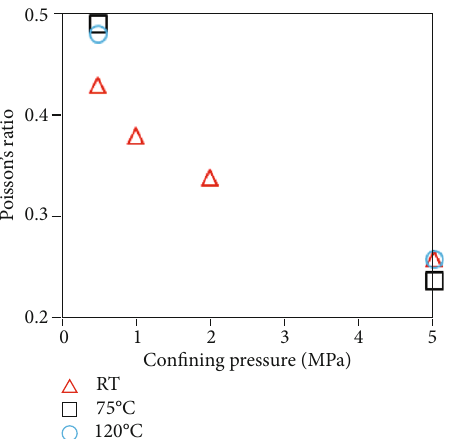
Figure 12: Characteristics of oil sand Poisson ’ s ratio under di ff erent con fi ning pressures and temperatures.